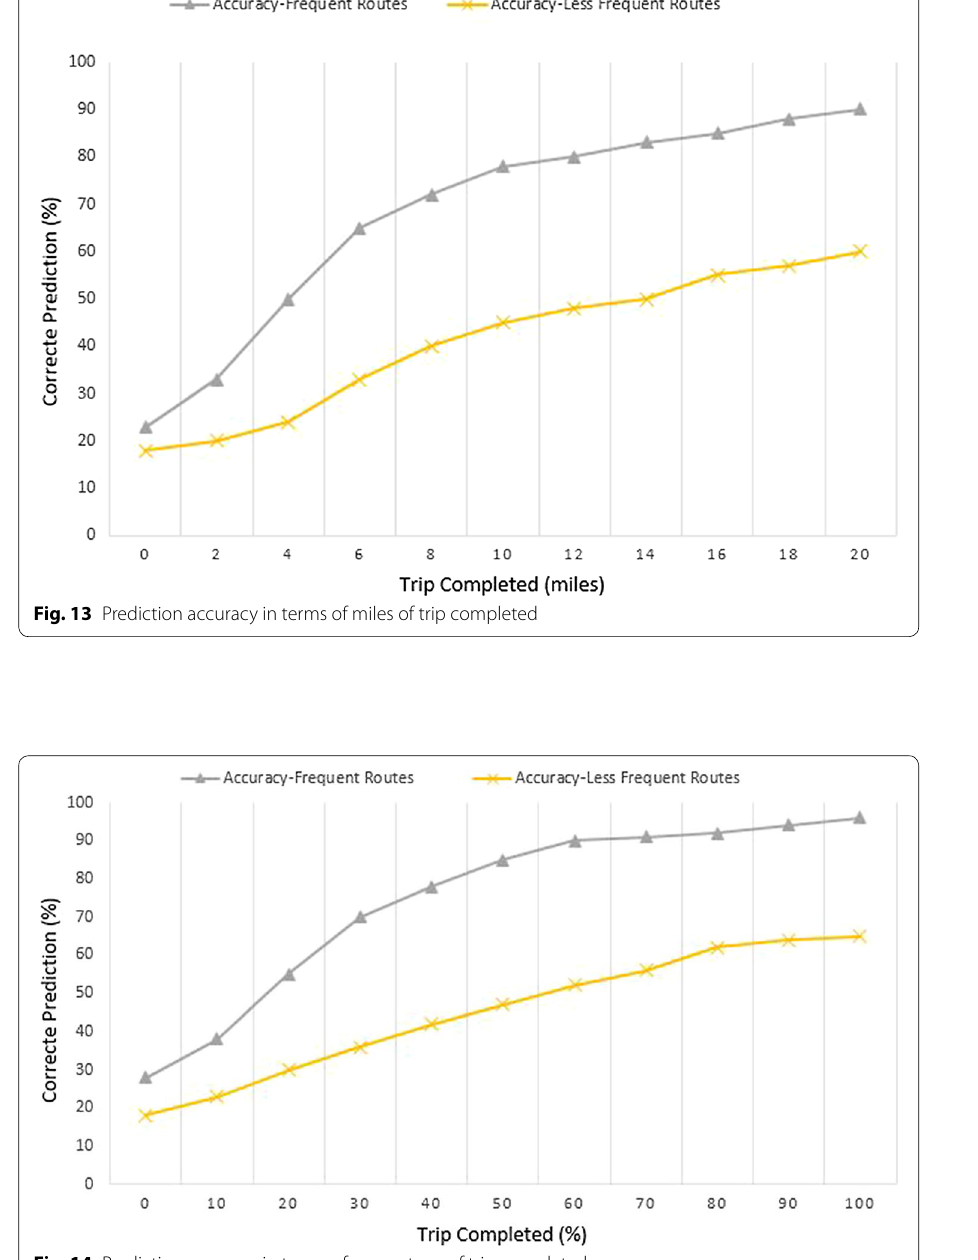
Fig. 14 Prediction accuracy in terms of percentage of trip